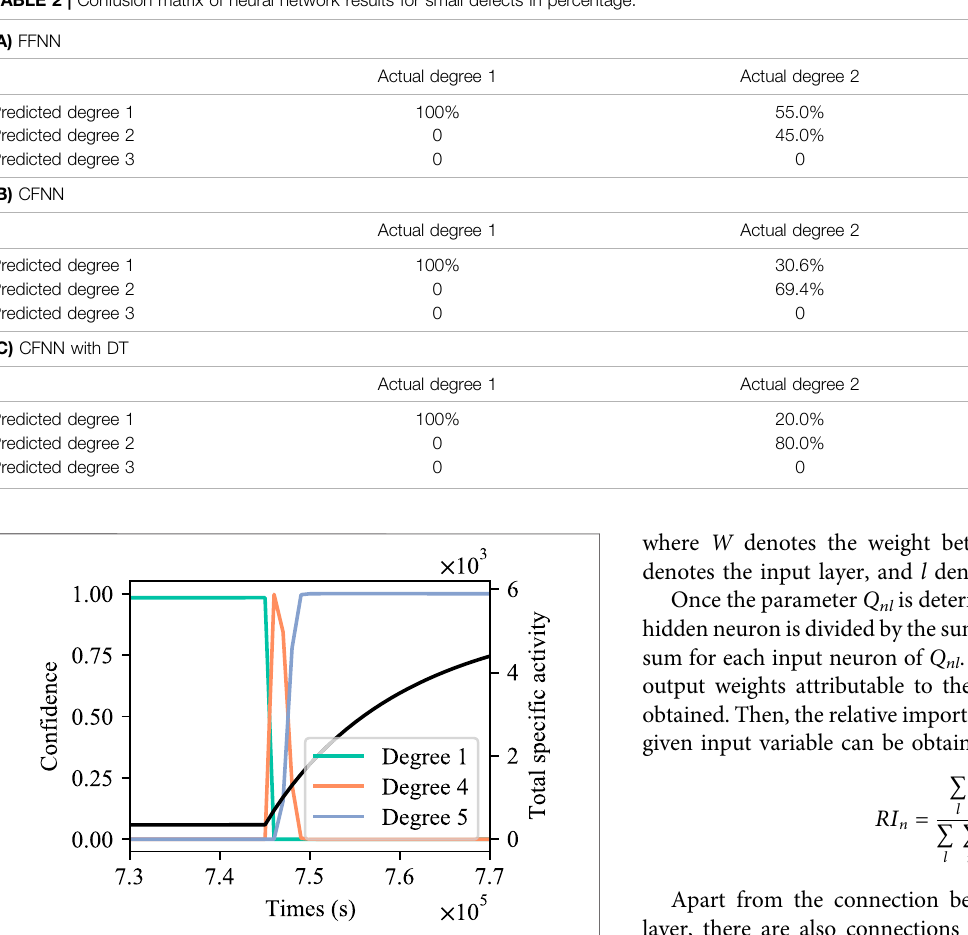
TABLE 2 | Confusion matrix of neural network results for small defects in percentage.